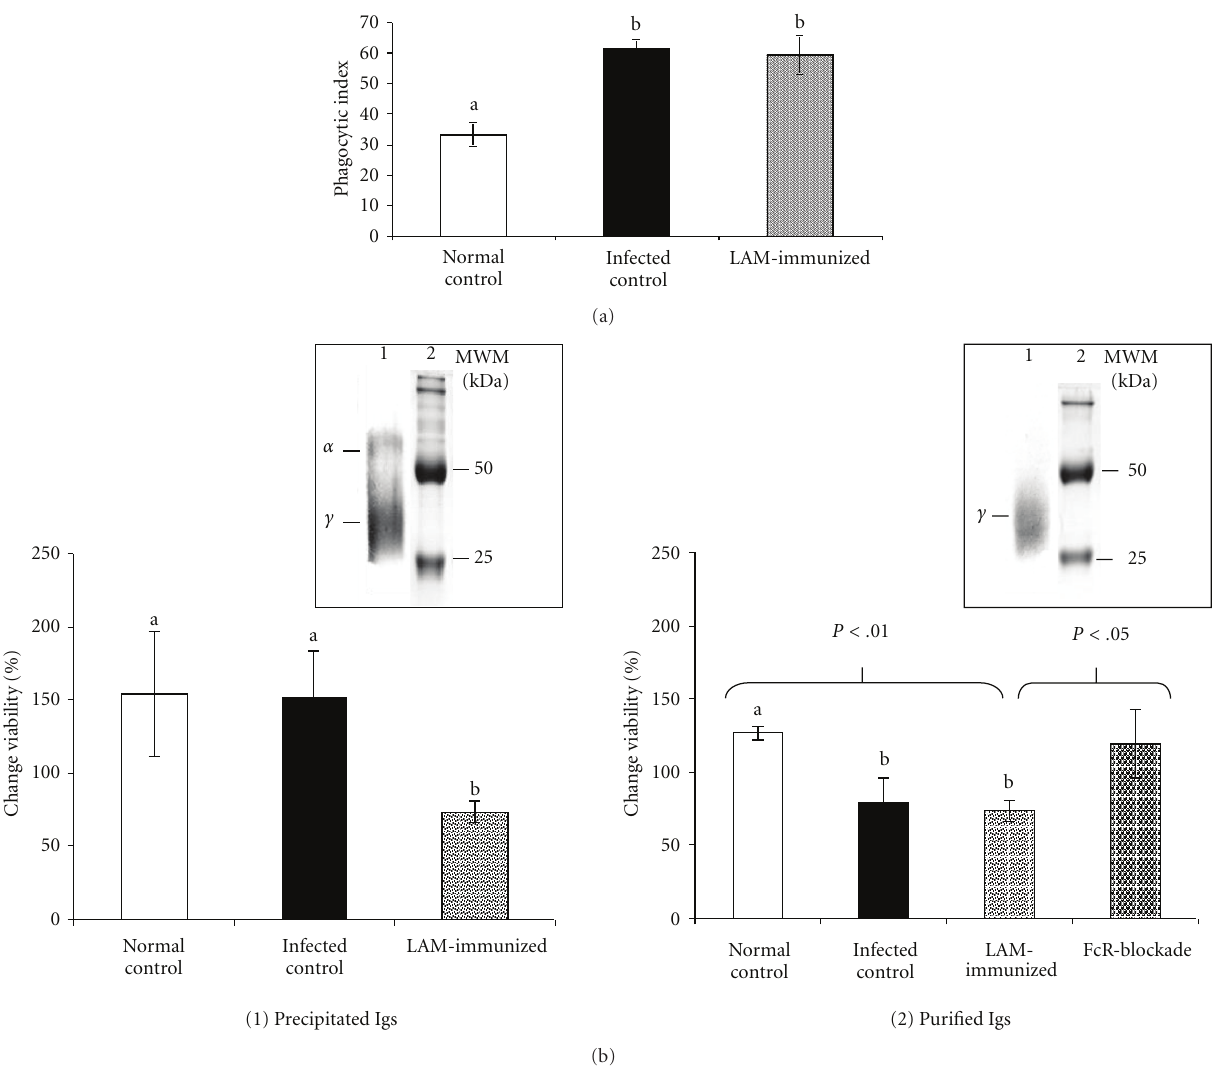
Figure 3: Functional e ff ects of antibodies: (a) on MAP ingestion. Results are expressed as mean phagocytic index for each treatment ± standard deviation; (b) on MAP intracellular viability. Results are expressed as % change in MAP viability 72h after the ingestion by Bomac cells. Boxes are representative of electrophoretic (lane 1) and SDS-PAGE (lane 2) pattern of precipitated and purified Igs. α and γ indicate alpha- and gamma- globulins bands. MWM: molecular weight markers. Error bars indicate standard deviation of three independent assays and di ff erent letters or numbers over bars represent significant di ff erences between